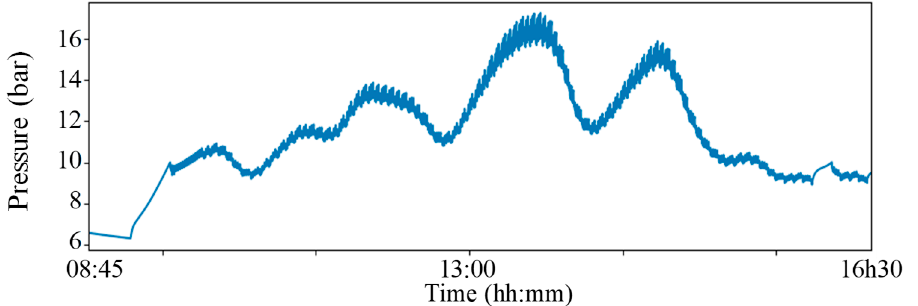
Figure 22. Simulated evaporator pressure during the disturbed day.